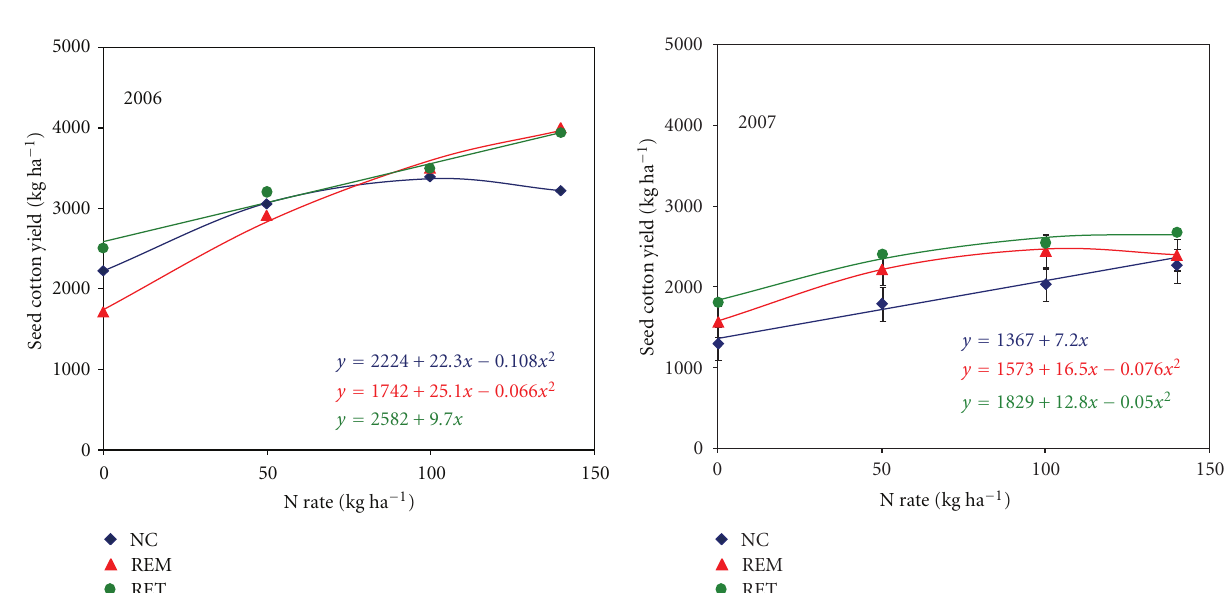
REM: rye residue removed. RET: rye residue retained.